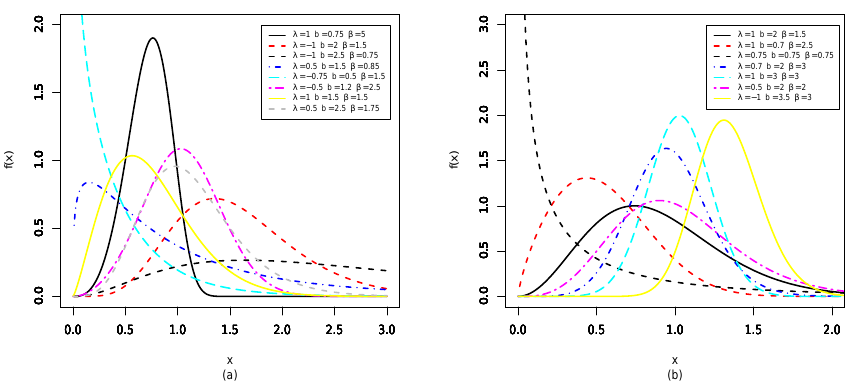
Fig. 1. Plots of the TExGW density function for some parameter values.